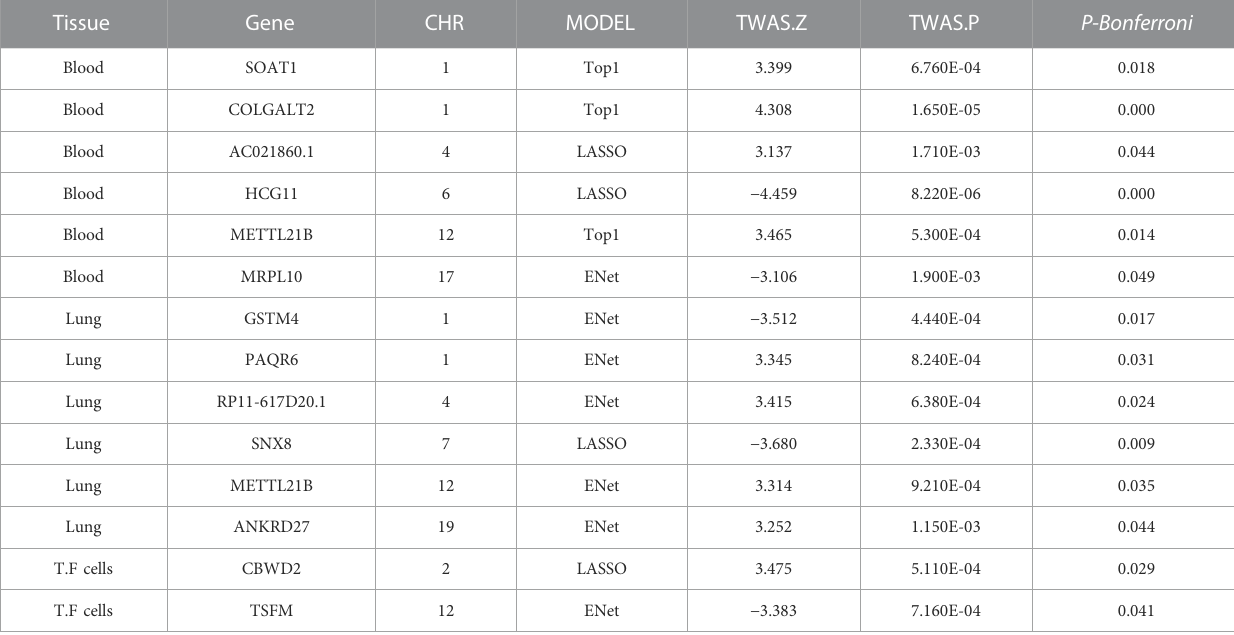
TABLE 2 Genes signi fi cantly associated with the risk of